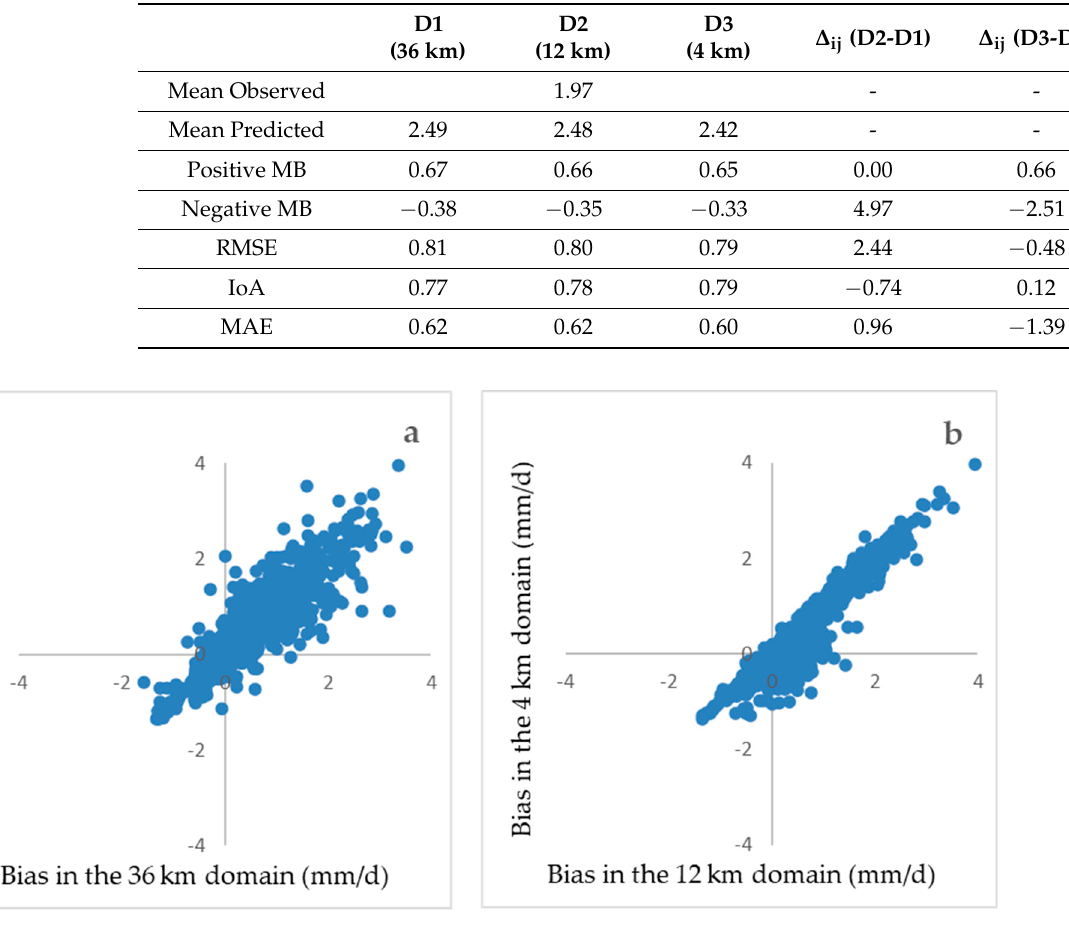
Figure 7. Scatter plots presenting ( a ) D1 ( x -axis) against D2 ( y -axis) and ( b ) D2 ( x -axis) against D3 ( y -axis) simulated annual precipitation biases for all grid cells considered.